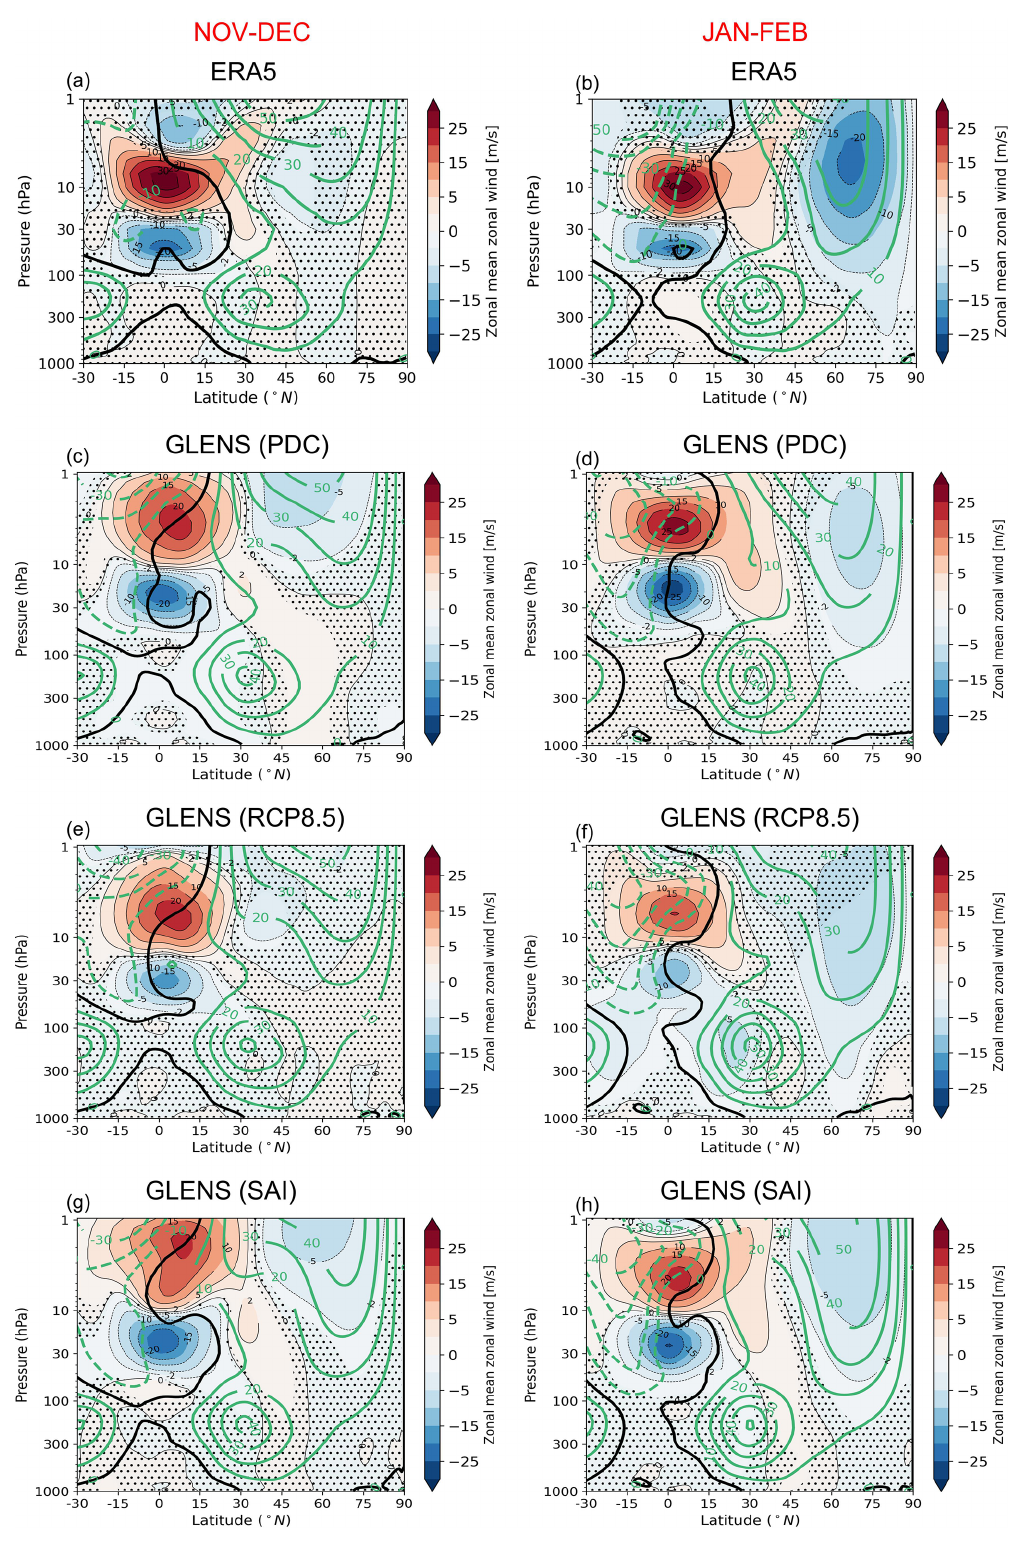
Figure 3. Latitude–pressure cross section of the composite differences between QBOe and QBOw (QBOe–QBOw) for November–December (left column) and January–December (right column) of the zonal-mean zonal wind. The stippled areas indicate regions where the changes are not statistically significant at the 95% level according to the t test. The green contours represent the zonal-mean zonal winds of the respective dataset or